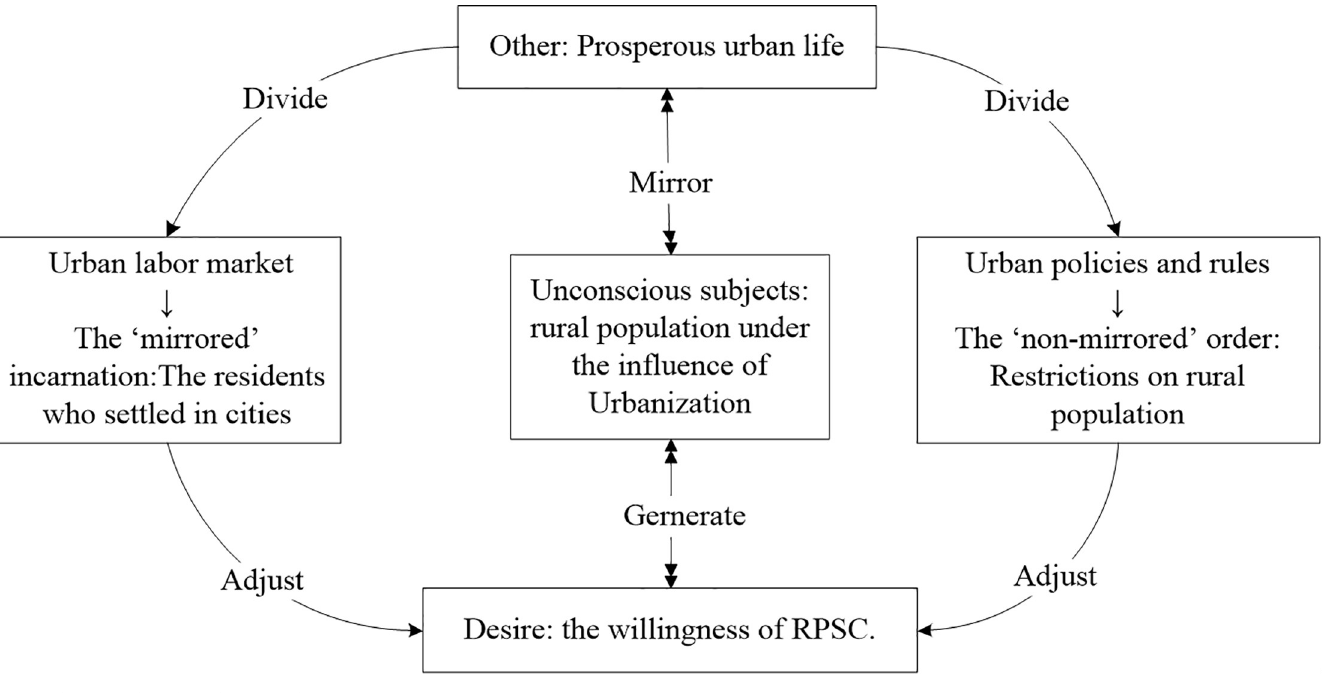
Fig 1. Theoretical analysis